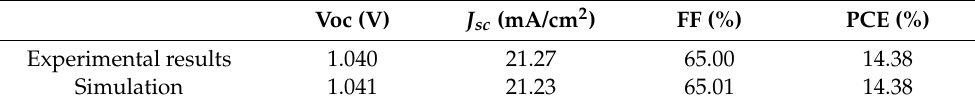
Figure 2. Validation of the simulated CPSC performance ( a ) JV curves and ( b ) EQE curves [18]. Table 3. Performance comparison of the experimental and calibrated CPSCs [18].